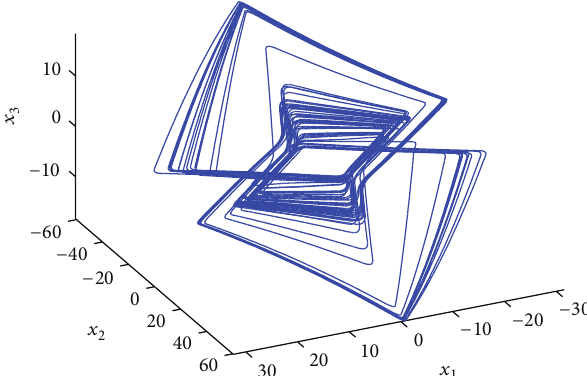
Figure 4: The phase portrait of (5) with 𝑓(𝑥) = 0.5(|𝑥+1|−|𝑥−1|) and 𝑘 = 60 .